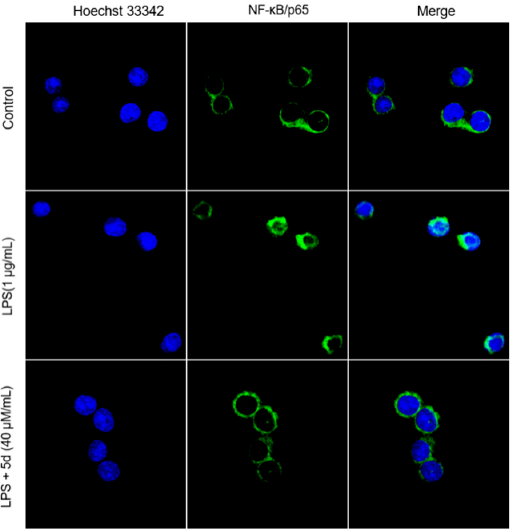
Figure 9. The localization of P65 in the cytoplasm and nucleus of Raw264.7 cells observed by immunofluorescence.